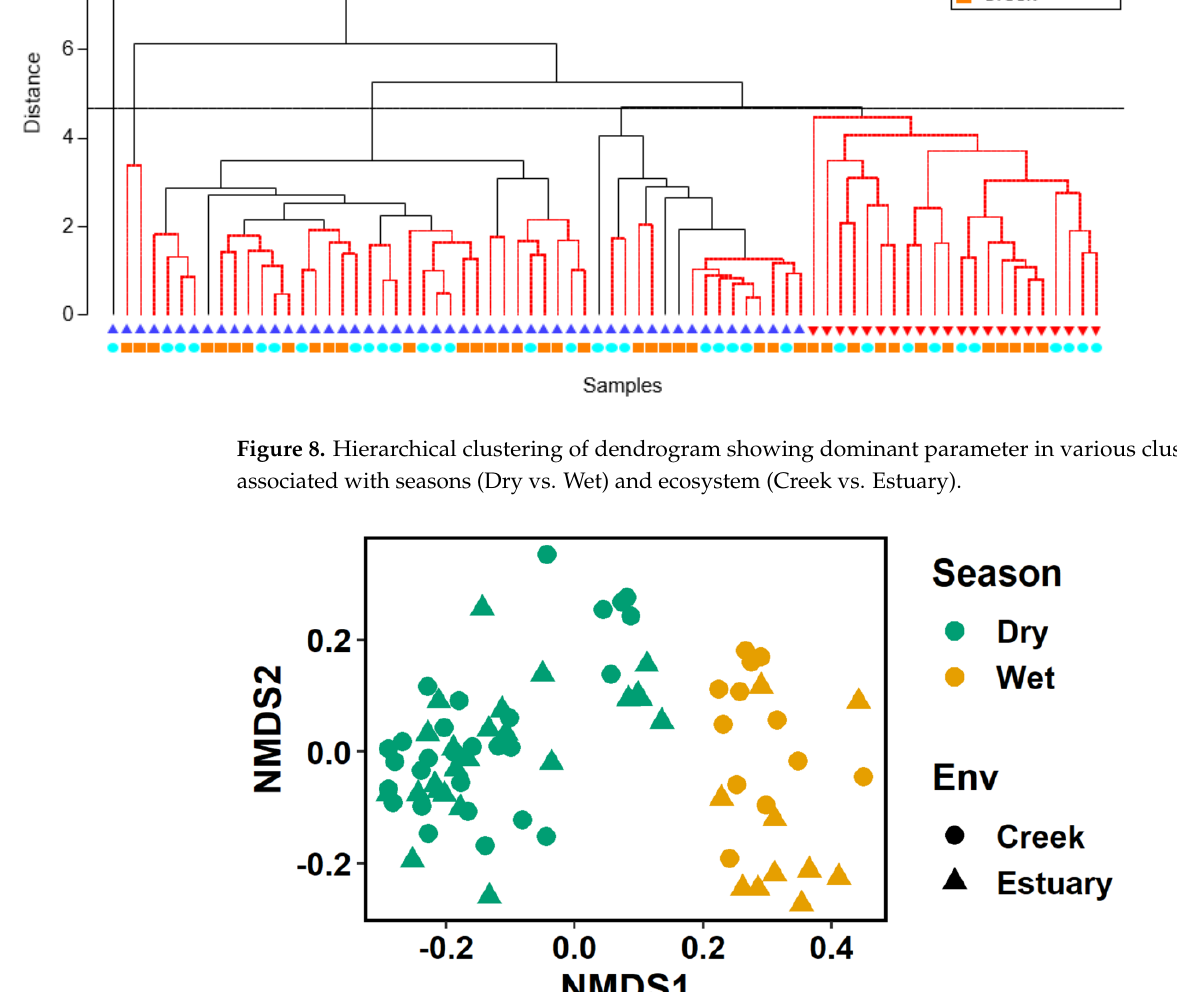
Figure 8. Hierarchical clustering of dendrogram showing dominant parameter in various clusters associated with seasons (Dry vs. Wet) and ecosystem (Creek vs. Estuary).